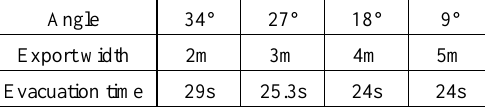
Table 4. Change export width as α changed